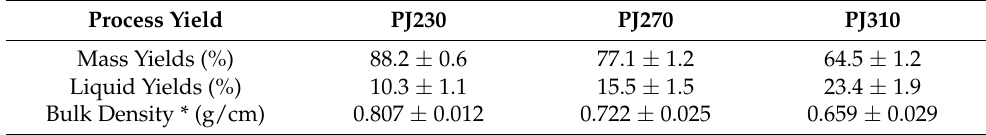
Table 1. Yields of torrefaction